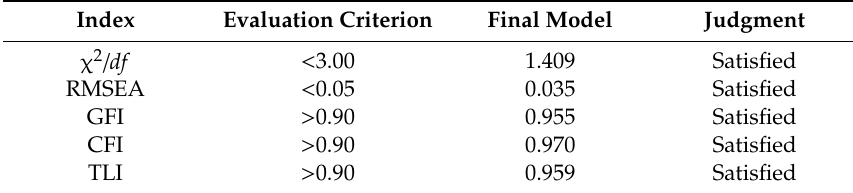
Table 4. Results of structural equation model (SEM) fit.